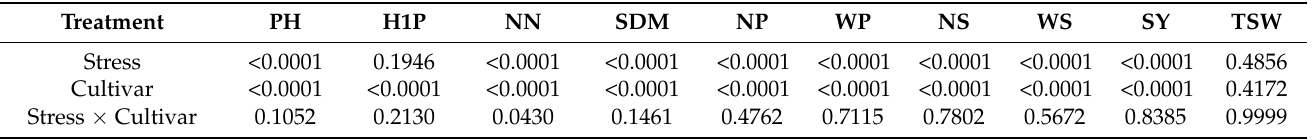
Table 1. Results ( p -values) of a two-way ANOVA on the effects of cold stress and cultivar treatments, and their interactions on the plant morphological features and elements of the yield structure.